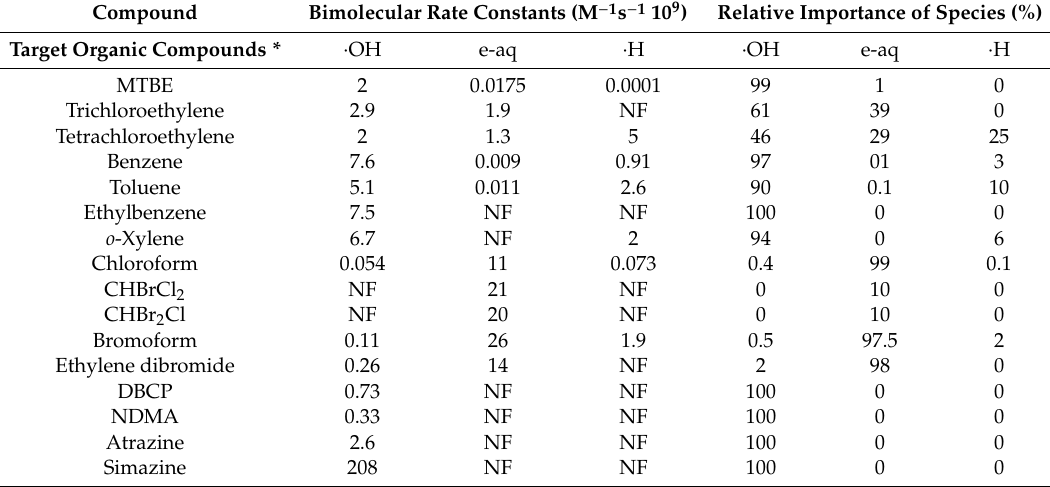
Table 4. Organic compounds removal e ffi ciencies by radicals formed due to water radiolysis (modified from